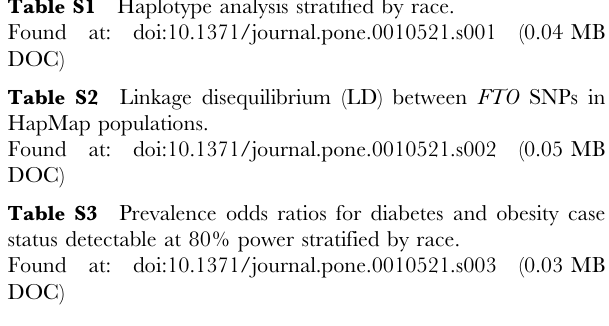
Table S1 Haplotype analysis stratified by race.